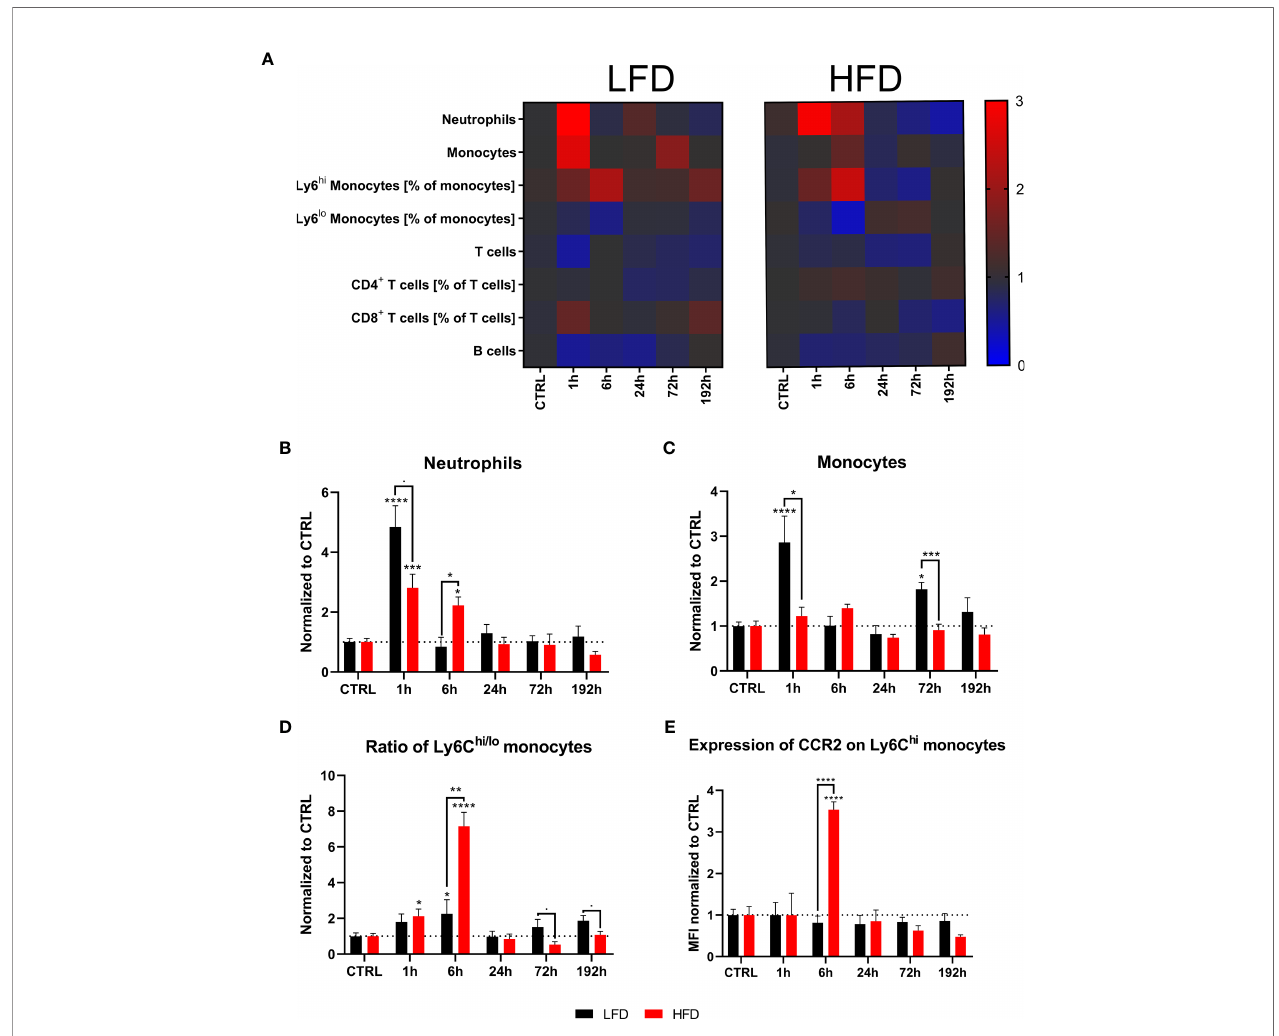
FIGURE 2 | Immune subsets in the blood at de fi ned time points during the fi rst 192 h analyzed with fl ow cytometry. Baseline-corrected heatmap displaying the ratios of immune subsets to control level (A) . Baseline-corrected (ratio) timelapse for neutrophils (B) , monocytes (C) , the ratio of Ly6C hi to Ly6C lo monocytes (D) , and the expression of CCR2 on Ly6C hi monocytes depicted as mean fl uorescence intensity (MFI) (E) . Statistics: two-way ANOVA with an uncorrected Fisher ’ s LSD test as follow-up was used to compare the level to the respective CTRL, signi fi cance indicators are displayed directly above the bar; unpaired two-tailed Student ’ s t -test was used for comparison of lean and obese mice at a speci fi c time point, signi fi cance indicators are displayed above a connector line. ▪ indicates p ≤ 0.1, * indicates p ≤ 0.05, ** indicates p ≤ 0.01, *** indicates p ≤ 0.001, **** indicates p ≤ 0.0001. Sample sizes: LFD CTRL = 8, LFD 1 h = 7, LFD 6 h = 5, LFD 24 h = 5, LFD 72 h = 5, LFD 192 h = 8, HFD CTRL = 7, HFD 1 h = 5, HFD 6 h = 5, HFD 24 h = 6, HFD 72 h = 5, HFD 192 h = 5. Data are displayed as mean ±